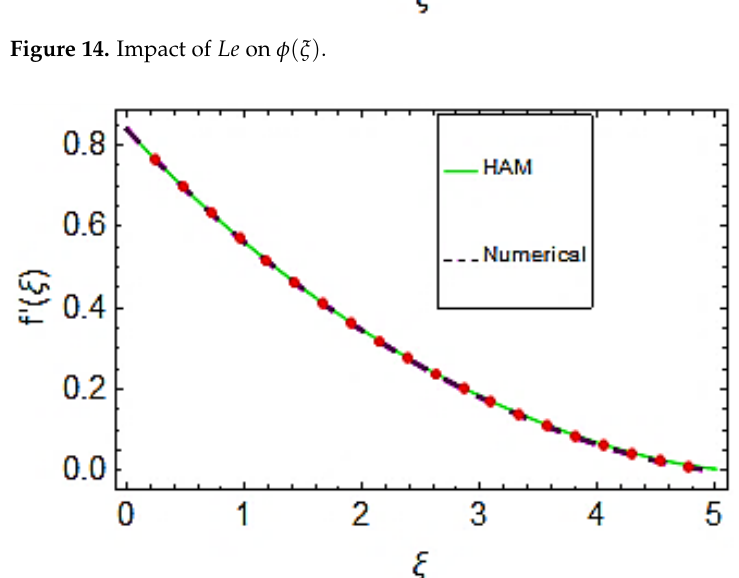
(cid:48) ( ξ ) ( ) f ξ′ . Figure 15. Assessment of HAM and numerical method for f ( ) f ξ′ .